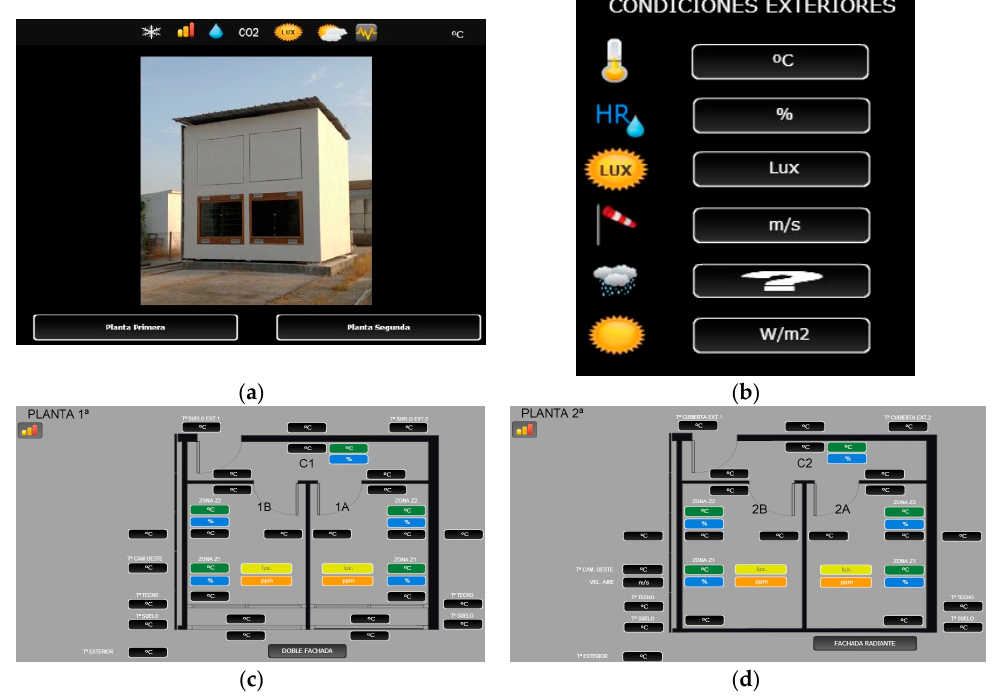
Figure 8. System monitoring via the web. On top, the access screen is shown, which allows us to select the first or the second prototype. Once a prototype is selected, one can select the different measurements (temperature, radiation, etc.). On the bottom right is the monitoring distribution for the two floors. ( a ) Acces screen; ( b ) External conditions; ( c ) First floor; ( d ) Second floor.